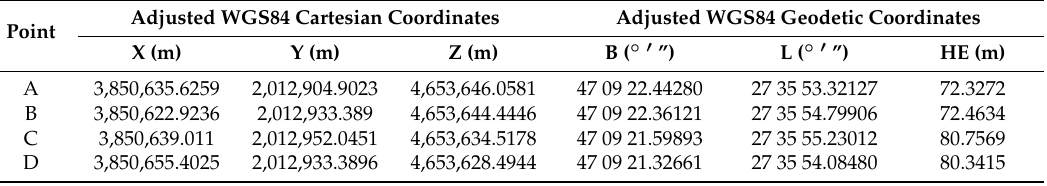
Table A1. The adjusted coordinates of GNSS network points.